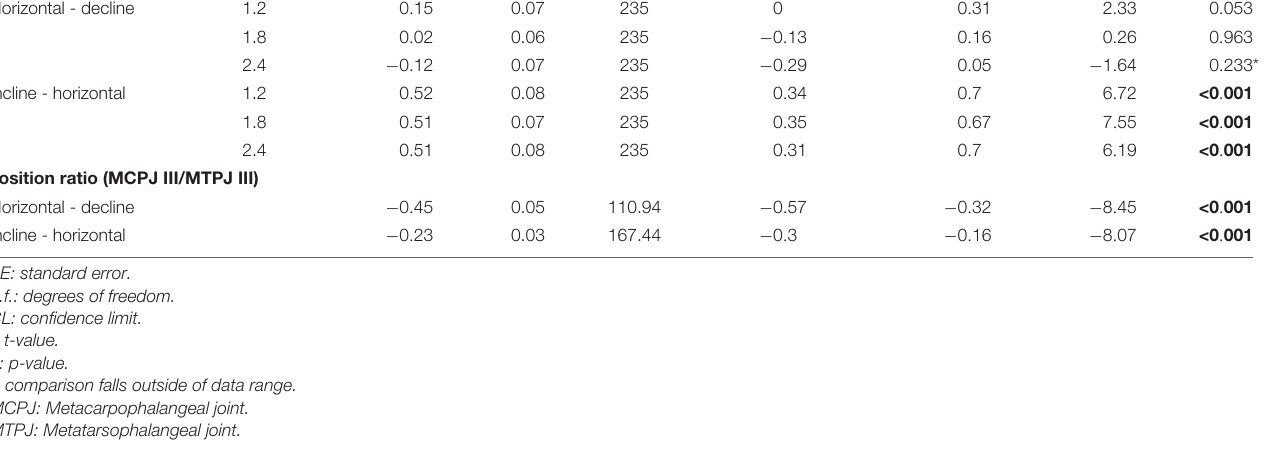
TABLE 5 | Post hoc contrasts for the regressions of the ratio of hand/foot distance on the trackway and the ratio of the positions of the MCPJ III and MTPJ III on the pole. Contrast Speed [ms − 1 ] Estimate SE d.f. Lower 95% CL Upper 95% CL t p Distance ratio (hand/feet) Horizontal - decline 1.2 0 . 15 0.07 235 0